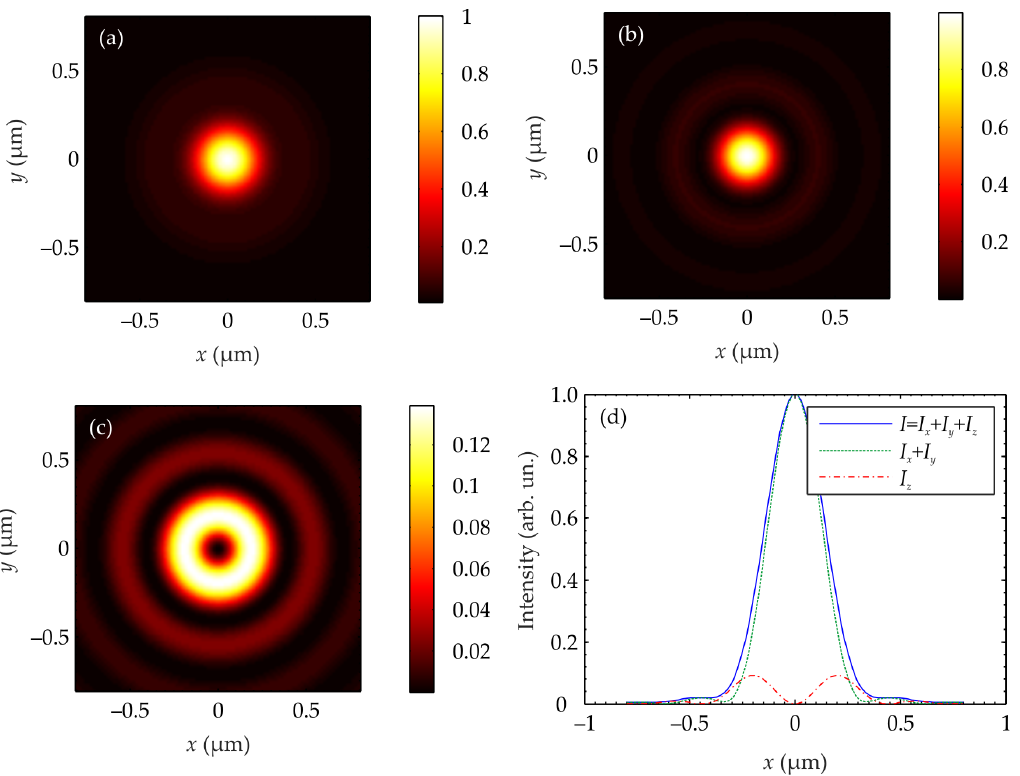
Figure 6. Distributions of intensity at the focus ( a ) and intensity components I r ( b ) and I z ( c ) when focusing light with an aplanatic lens with NA = 0.95. The intensity profile along x ‐ axis ( d ). Thus, comparing the focusing of a Gaussian beam (6) with circular polarization us ‐ minimum focal spot size for a diffractive lens is FWHM = 0.55 λ and is achieved with a larger and equals FWHM = 0.58 λ for a numerical aperture NA ≈ 1.